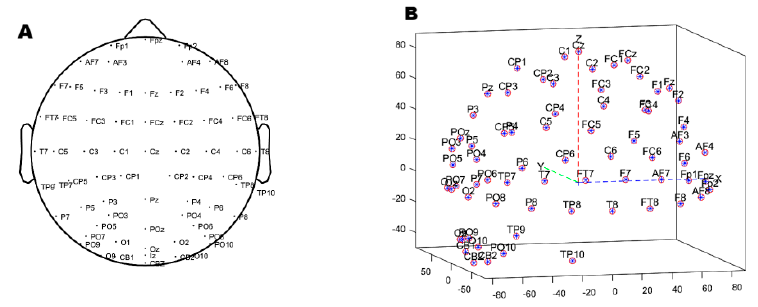
Figure 4. Electrode position. ( A ) 2D top view ( B ) 3D side view.